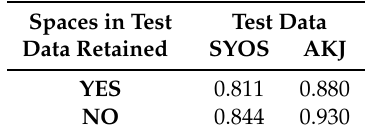
Table 9. US-ISP model (with 9-gram vectors): F-score for word boundaries not indicated in original